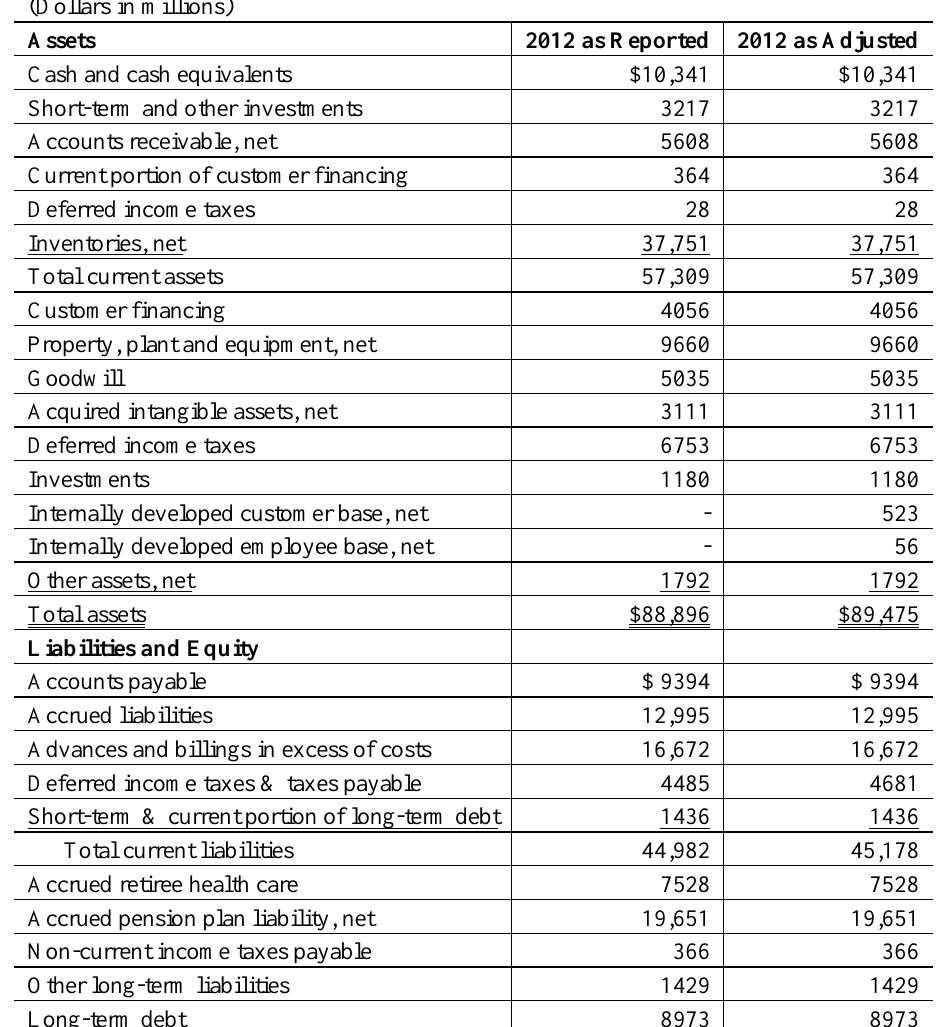
Table 2. The Boeing Company Consolidated Statement of Financial Position December 31,